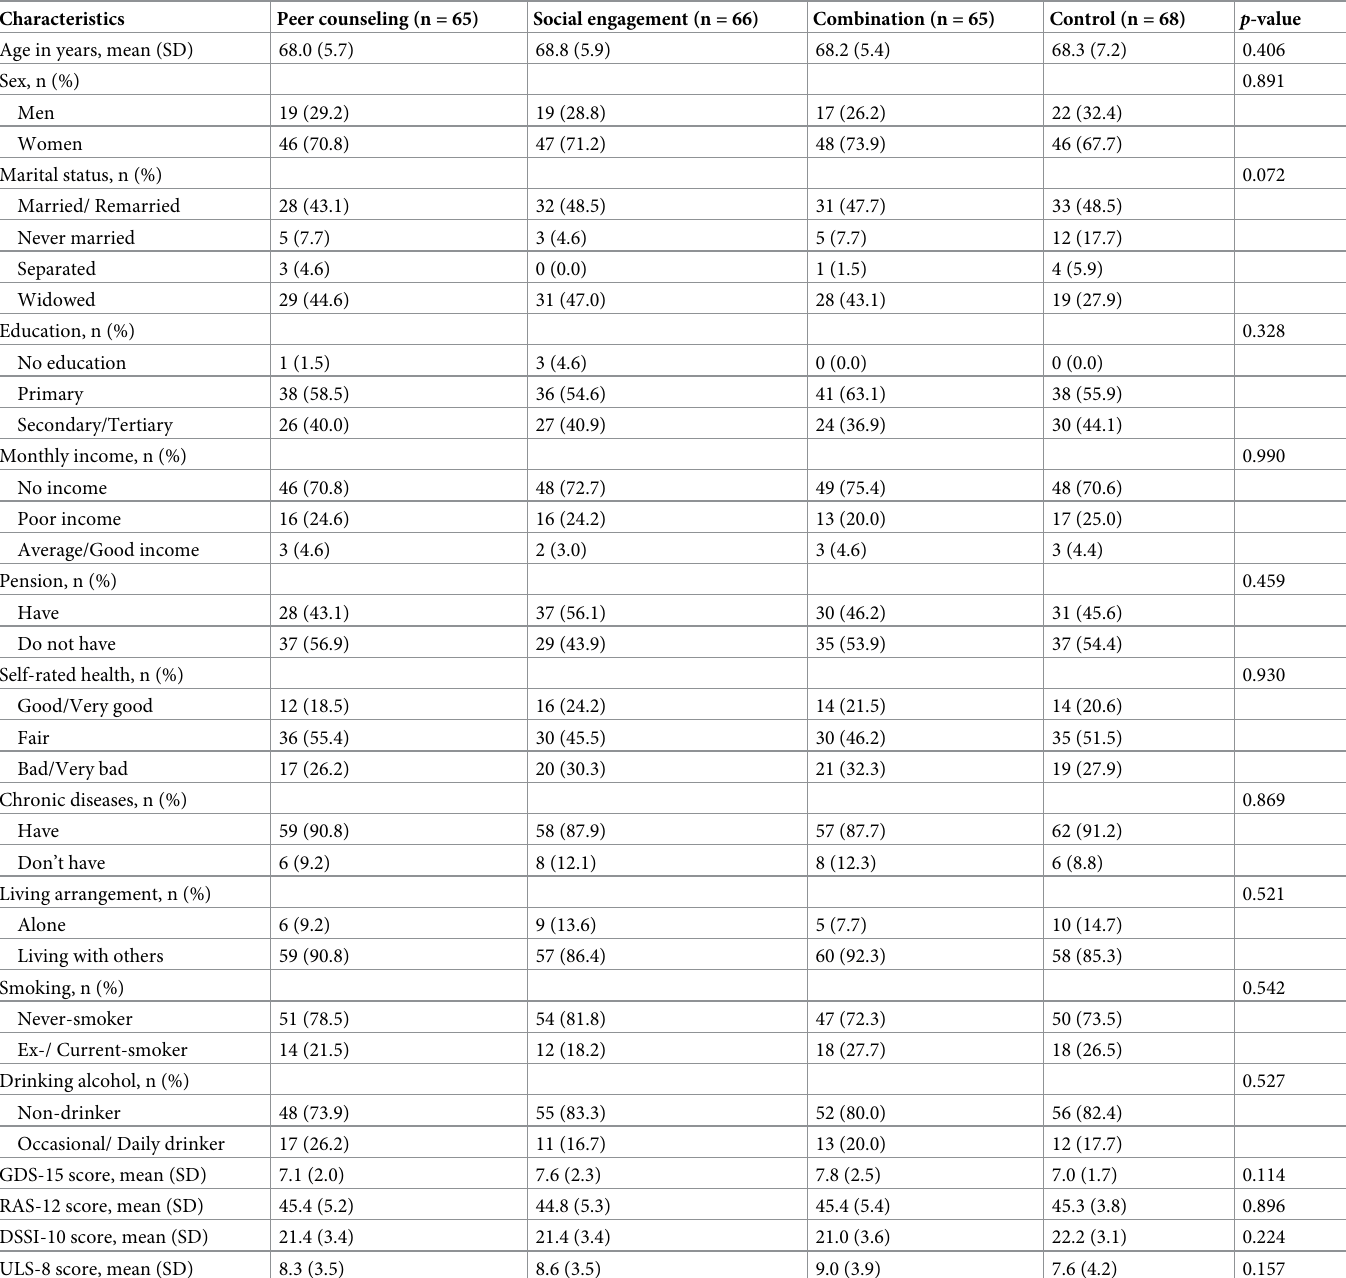
Table 1. Characteristics of community-dwelling senior citizens at risk for depression at baseline ( N = 264).